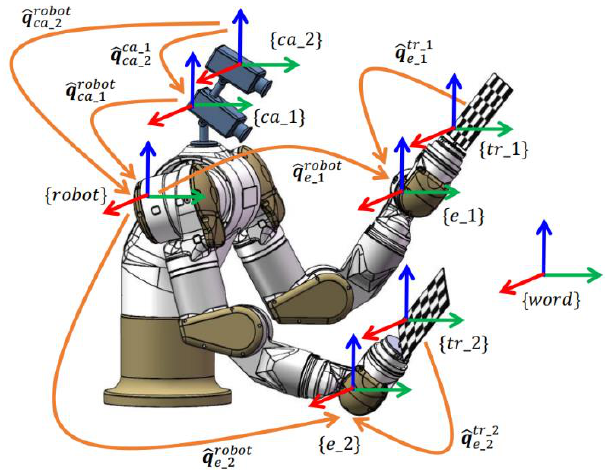
Figure 1. Example setup of the coordinate systems in the dual-arm hand – eye calibration.